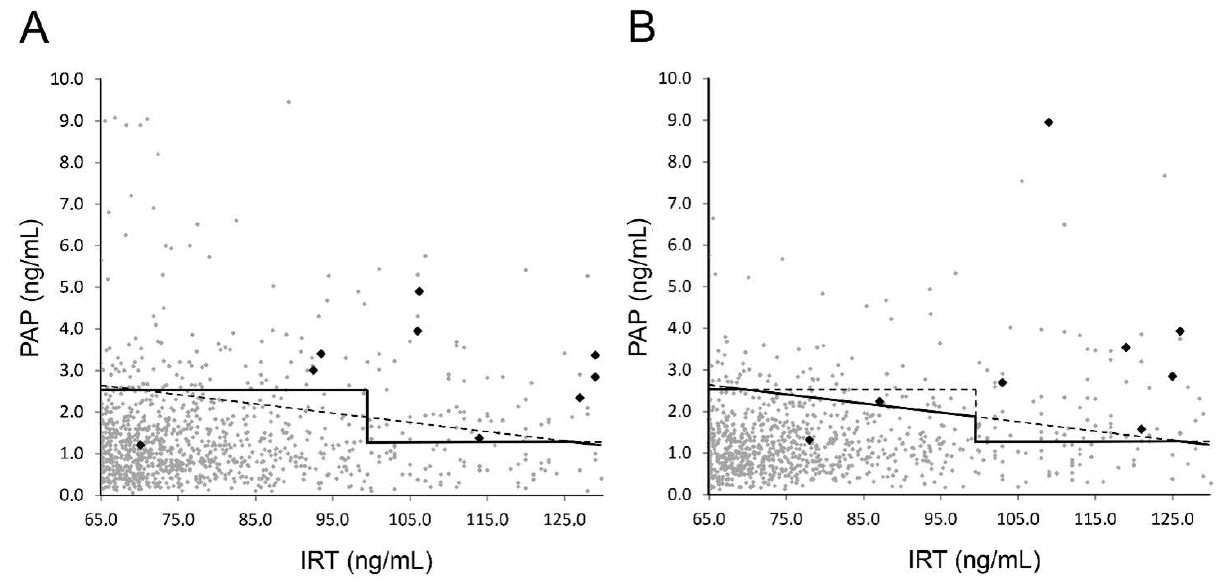
Figure 2. PAP vs. IRT values from first DBSs. Values of samples with IRT between 65 and 130 ng/mL eligible for PAP analysis according to the screening scheme for ( A ) first period and ( B ) second period are plotted. Solid lines indicate used cut-off values for request of second card; dashed lines give comparison to alternative strategies (see main text). Black data points indicate confirmed CF